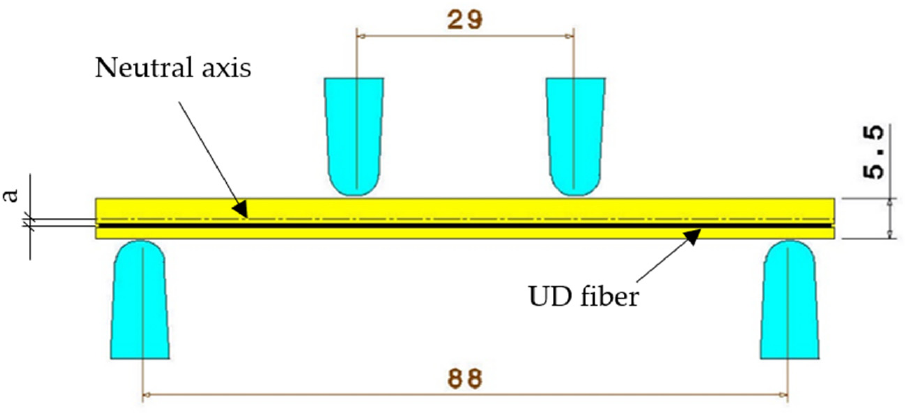
Figure 4. The four bending test setups with an asymmetric UD fiber position.